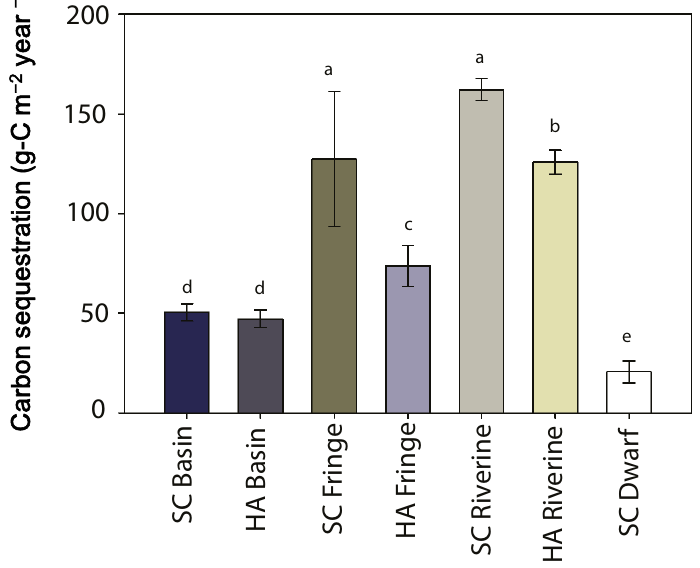
Figure 7. Carbon sequestration rates for seven different mangrove sites in four different hydrogeological settings for the hydrologically disturbed Hamilton Avenue Creek (HA) and reference Susan’s Creek (SC). Bars depict mean ( ˘ standard error) carbon sequestration values ( n = 3). Similar letters indicate no statistical differences, alpha equals